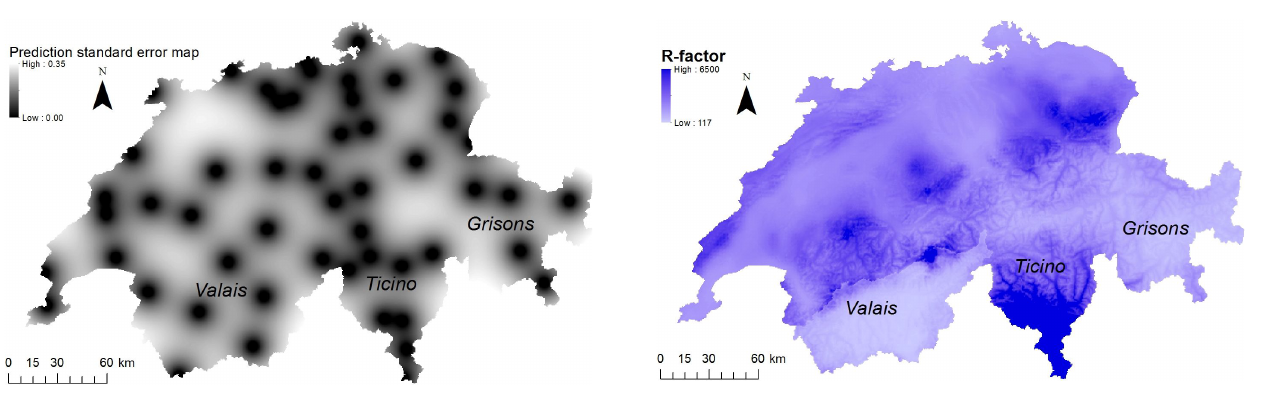
Fig. 3. The prediction standard error map for the kriging of the residuals resulting from the multiple regression.